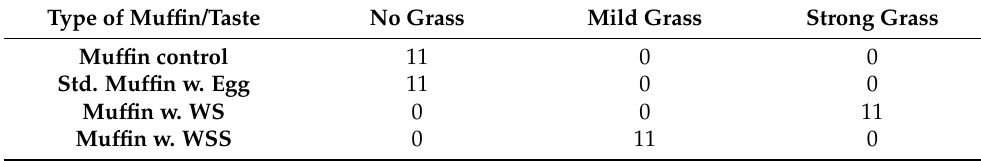
Table 9. Intensity of grass taste in the different muffin types reported by the focus